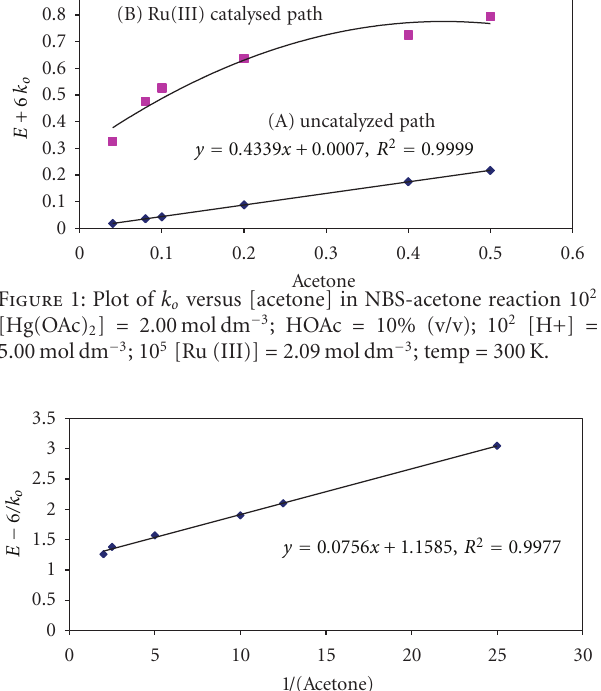
Table 1: E ff ect of variation of [substrate] 10 2 [Hg(OAc) 2 ] = 2.00mol dm − 3 ; HOAc = 10% (v/v); 10 2 [ H + ] = 5.00 moldm − 3 ; 10 5